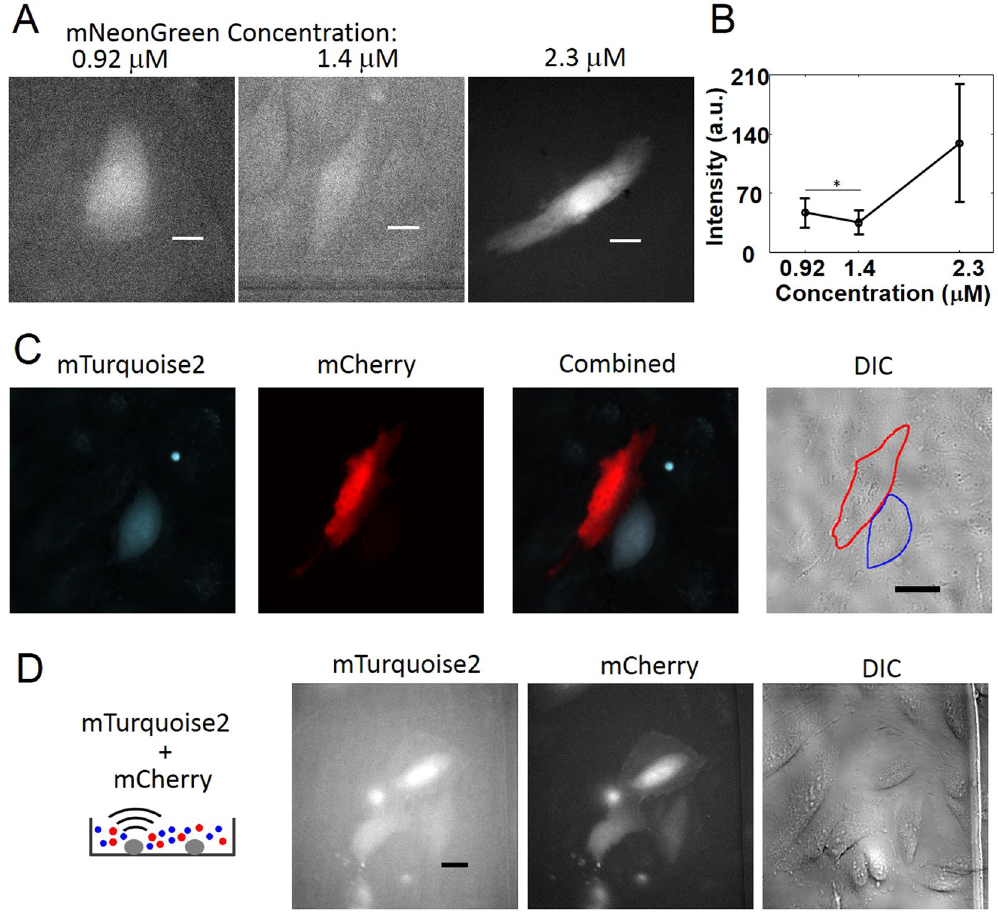
Figure 4. Protein delivery. The Vp and tw of each electrical pulse were 22 V and 18 μ s, respectively, and the NP = 1. All images were taken 30 minutes after acoustic-transfection. ( A ) Representative images of the mNeonGreen (mNG) protein delivery under the mNG protein concentrations of 0.92 μ M, 1.4 μ M, and 2.3 μ M are shown. ( B ) Six cells were used to calculate the fluorescence intensity of the mNG at each data point. Error bars represent + / − one SD. Asterisk ( * ) indicates that fluorescence intensities between 0.92 μ M and 1.4 μ M are not statistically significant ( p value = 0.170). ( C ) The sequential delivery of mCherry (mCR) and mTurquoise2 (mTQ2) recombinant proteins into two neighboring target cells was confirmed. ( D ) Simultaneous delivery of mTQ2 and mCR into three neighboring HeLa cells was successfully performed. This shows a potential for a direct delivery of multiple reprogramming proteins for iPSC generation. All proteins have a molecular weight of approximately 27 kDa. Scale bars indicate 20 μ